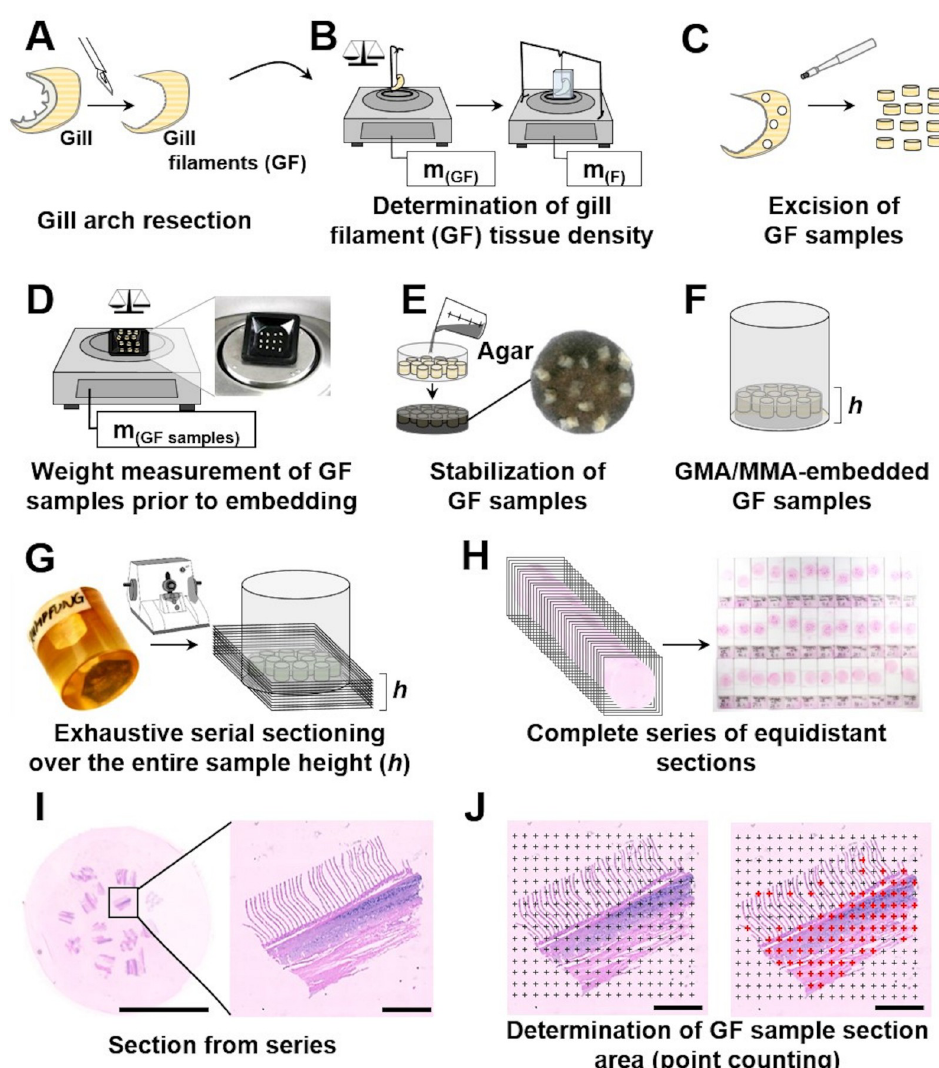
Fig 11. Determination of volume shrinkage of gill filaments due to embedding in plastic embedding media. A-D. Volume determination of SUR sampled GF samples prior to embedding. After dissection of the gill arch ( A ), the density of the (fixed) GF samples is determined ( B ). The GF samples are excised by biopsy punch of 0.2 cm diameter ( C ) and the samples weight is recorded ( D ). GF sample volume is calculated from GF density and sample weight (submersion technique, refer to Section 8 and Eq 1 ). E-H. Embedding of GF samples in plastic medium and exhaustive serial sectioning of the embedded samples. For stabilization and visual contrast, the GF samples are embedded in ink-dyed black agar ( E ) and subsequently routinely processed and embedded in plastic embedding medium ( F ) (here: GMA/MMA). The embedded samples are then exhaustively sectioned over the entire sample height (h) with a defined section thickness ( G ). From the section series ( H ), sections are taken in a defined interval ( e . g ., every 40 th section) and mounted on a glass slide. The factual thicknesses of the individual sections are determined by spectral reflectance measurement (not shown) [80]. I-J. Determination of GF sample section areas in equidistant serial sections. The section profile areas of all samples in all examined sections are determined (here: point counting). Digital microscopic section images are randomly overlaid with a grid of equally spaced test points (crosses) of known distance at the given magnification ( i . e ., every point (P) is associated with a defined area (A)). The number of points hitting GF section profiles are counted. Since the entire height (h) of the GF samples was sectioned into equidistant, parallel sections, the volume of the embedded GF samples can be calculated according to the principle of Cavalieri [24,59,63], from the total section profile area of all samples in all sections (A (GF sample section profiles) ) and the mean distance between two examined sections ( i . e ., section thickness x section interval). A (GF sample section profiles) is calculated from the total number of counted points ( ∑ P) and the area associated with each point (A/P) (refer to Eqs 2 and 4 ). The proportional volume shrinkage of GF samples associated with the embedding in the histological plastic embedding medium is calculated from the quotient of the sample volume prior to and after embedding. The linear tissue shrinkage factor (f s )